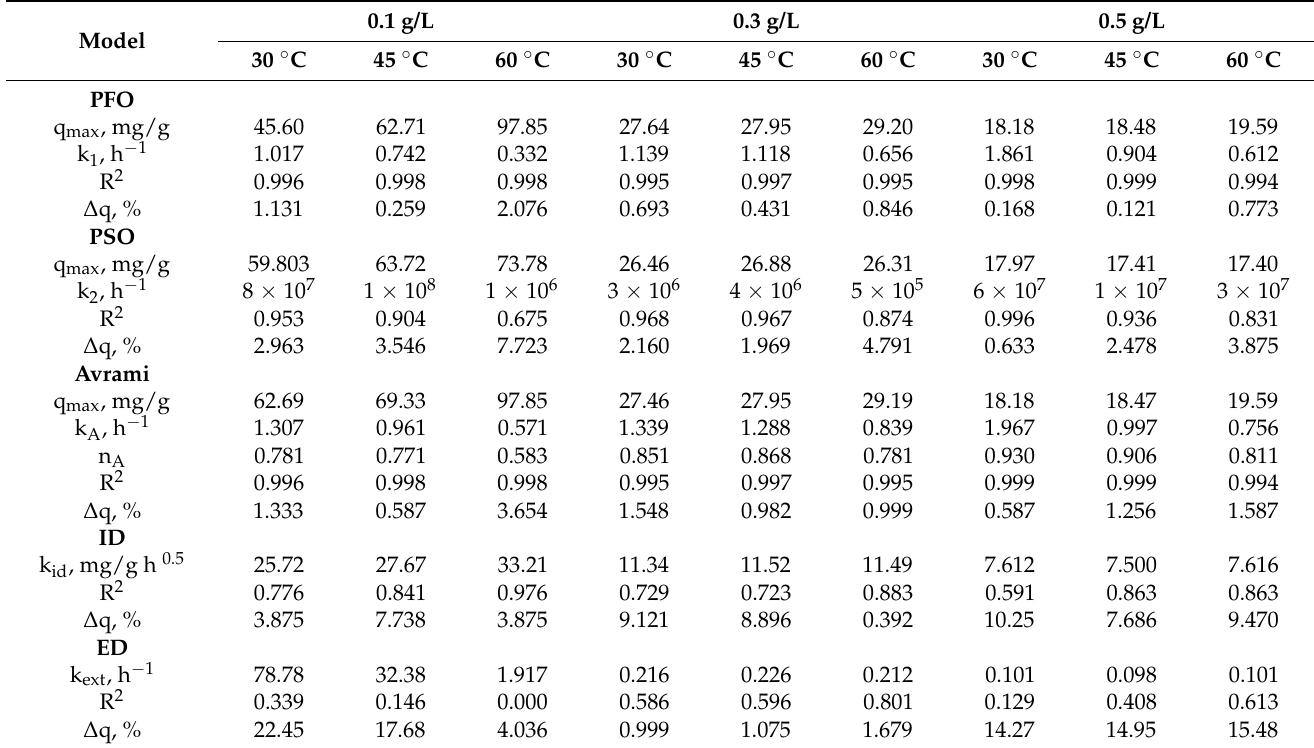
Table 6. Kinetic parameters for PR adsorption with WLW.